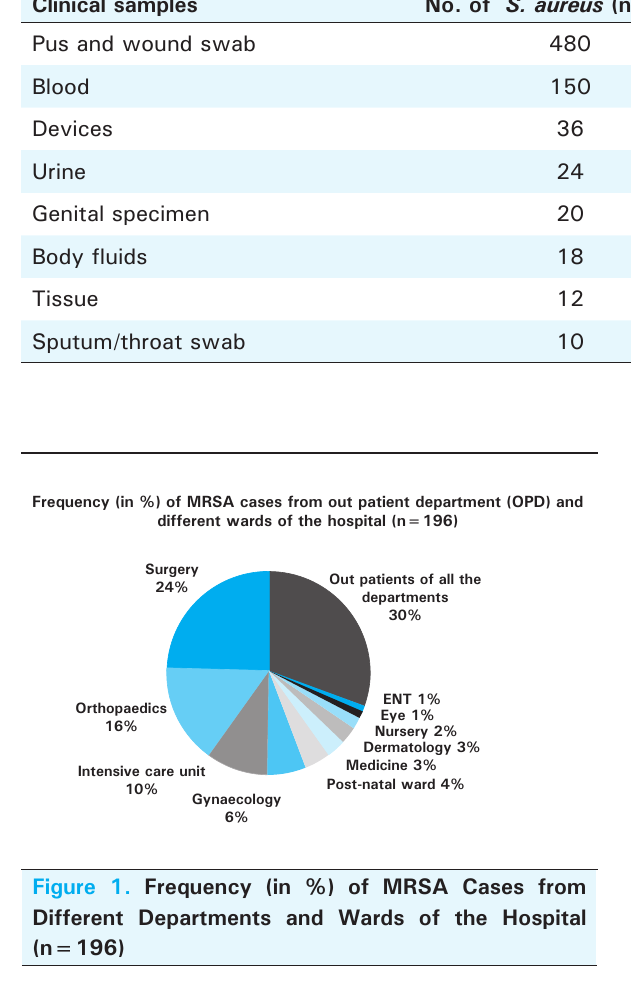
table 1. number and Percentage of Isolated MrsA from different clinical samples clinical samples